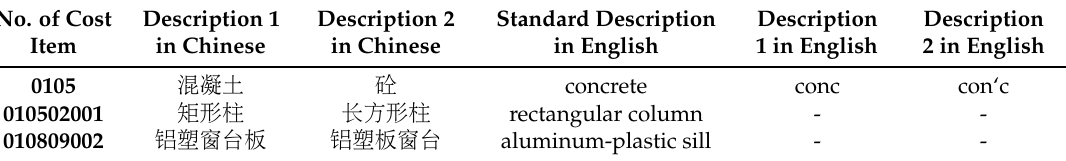
Figure 6. Structure of the terminology dictionary. Table 1. Examples of records in the terminology dictionary.